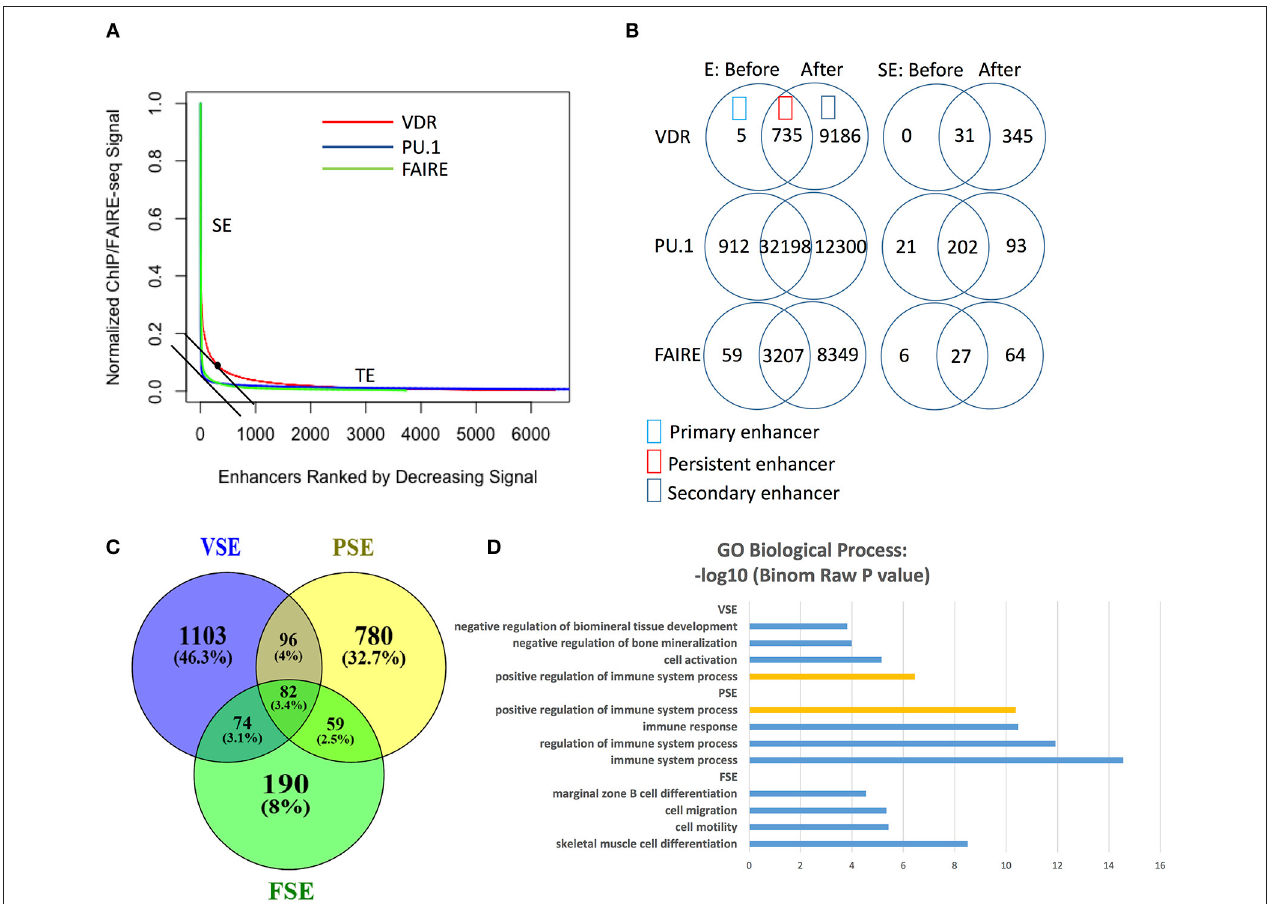
FIGURE 1 | VDR, PU.1, FAIRE identify different SE regions with different genes nearby and gene function enrichment, respectively. (A) The (signal density)/(density rank) curve for SE calling from VDR, PU.1 and FARIE. (B) The number of enhancers (E) and super-enhancers (SE) before and after 1,25(OH) 2 D 3 stimulation. (C) The Venn overlap figure for the gene list near VSE, PSE and FSE in 50kb regions. VSE, VDR SE; PSE, PU.1 SE; FSE, FAIRE SE. (D) The enrichment analysis of GO biological process gene set for VSE, PSE and FSE; orange bar: the shared process between VSE and PSE (GEO data shown in Table 1 ).